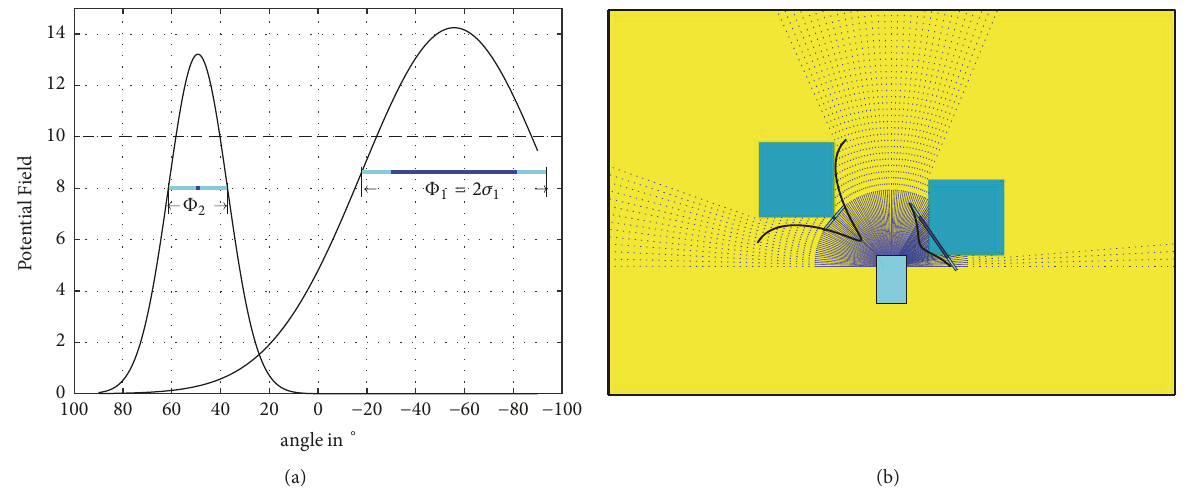
Figure 8: (a) Gaussian likelihood of each obstacle and (b) illustration with vehicle and